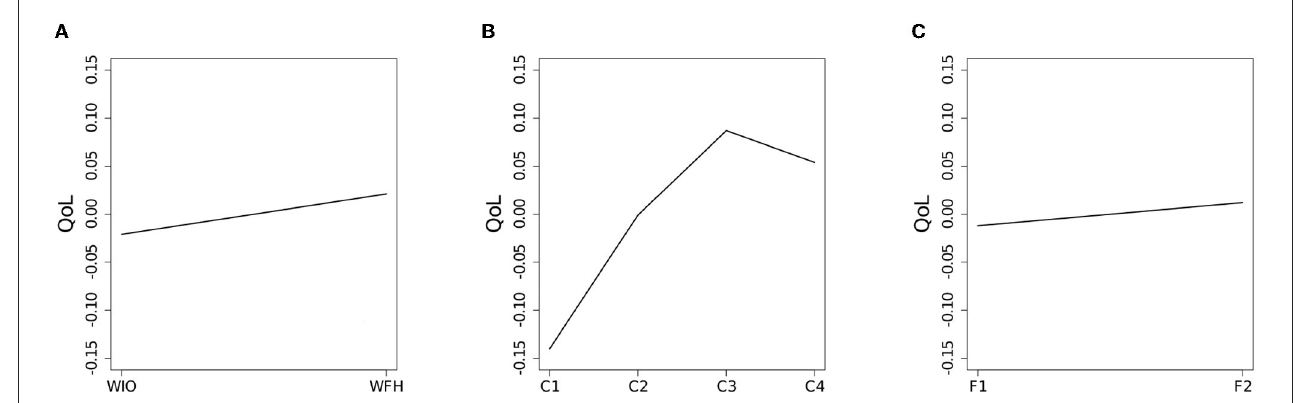
FIGURE1 The mean scores of QoL for (A) the work mode, (B) the social contact quantity, and (C) the face-to-face contact ratio.